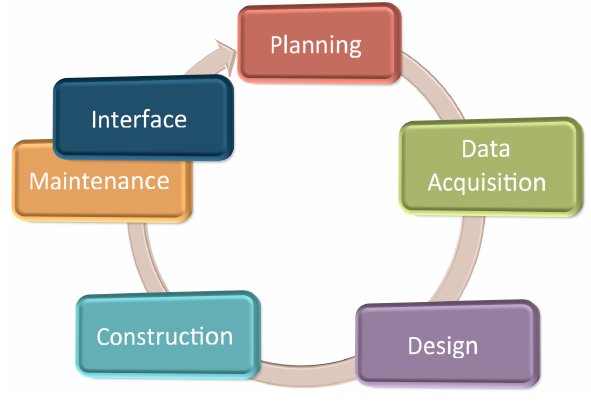
Figure 1. Feature data life